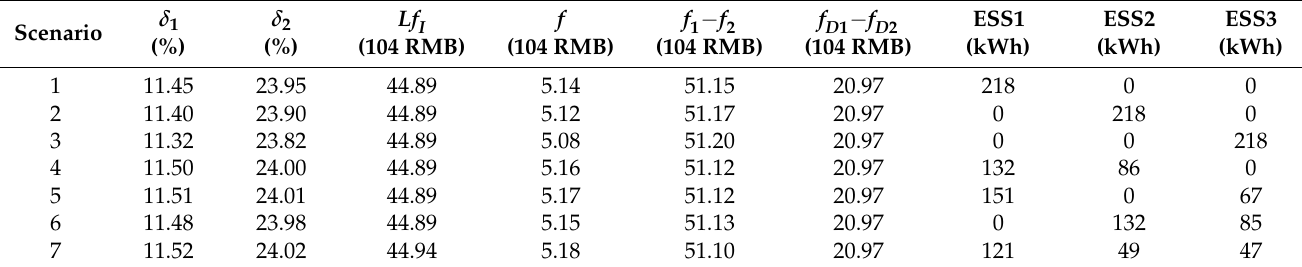
Table 1. Result comparison of ESS configuration under different